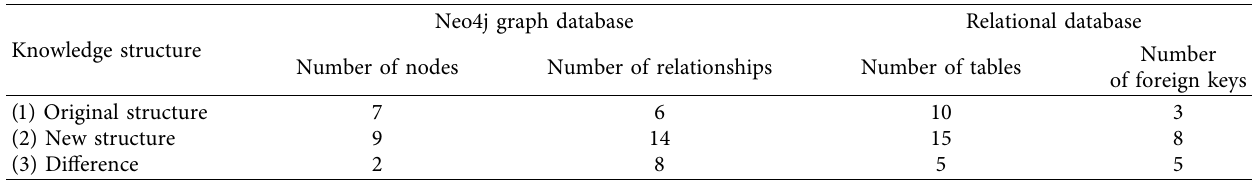
Figure 14: A partial structure of domain knowledge of bridge maintenance. Table 3: Comparison of results based on diferent knowledge representation methods.